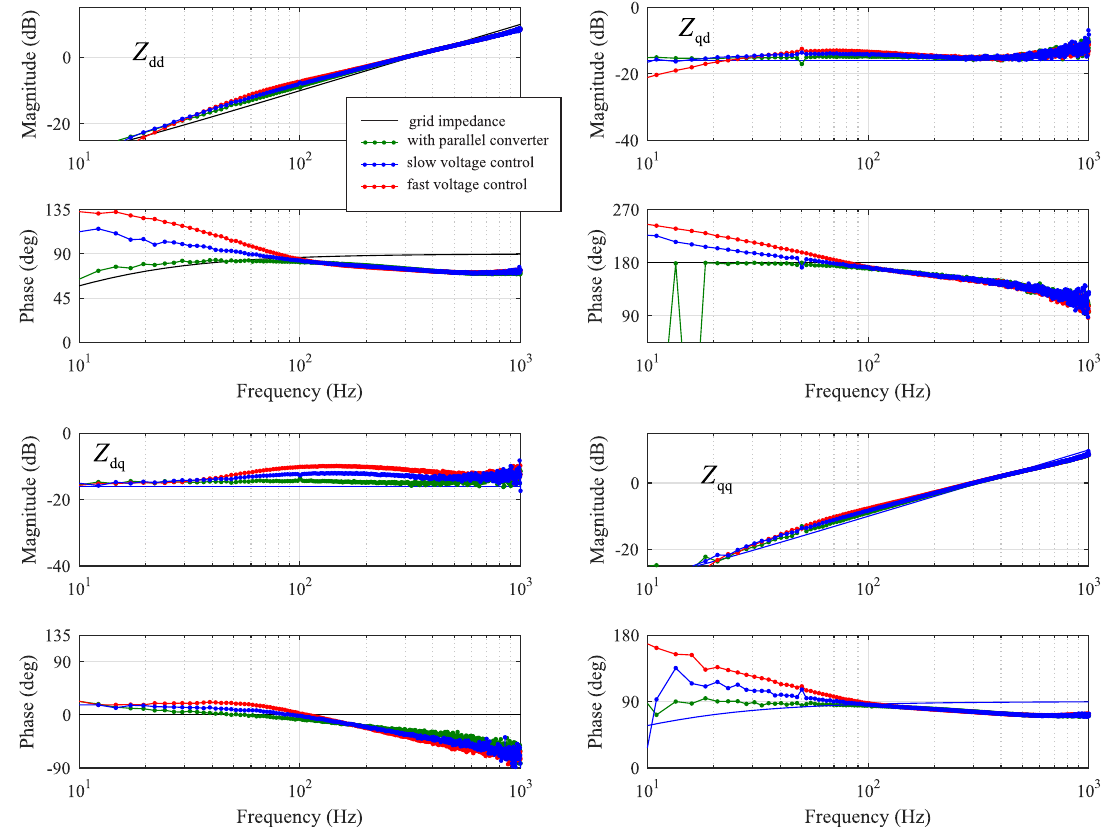
Figure 14. Measured impedance with parallel-connected device with additional voltage